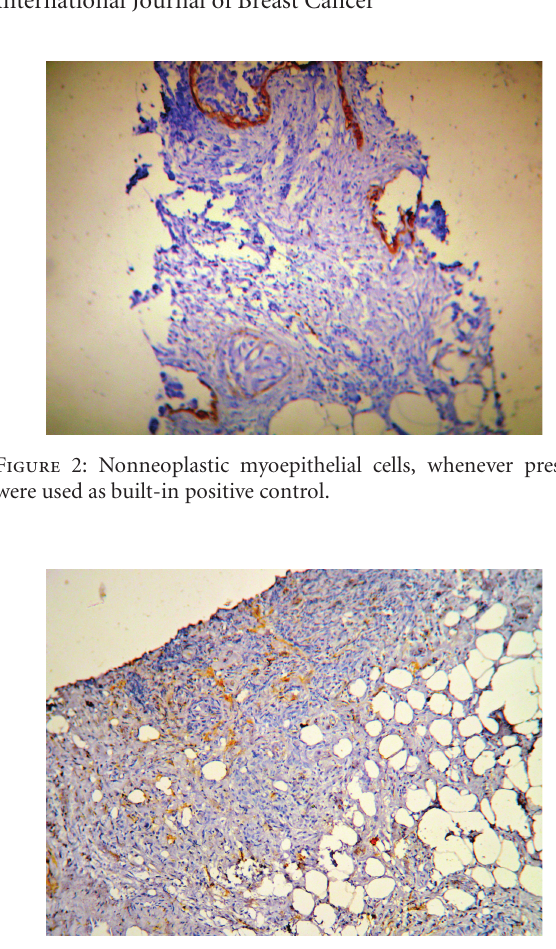
Figure 3: Weak CD10 stromal staining. Table 3: Correlation of CD10 with ER.